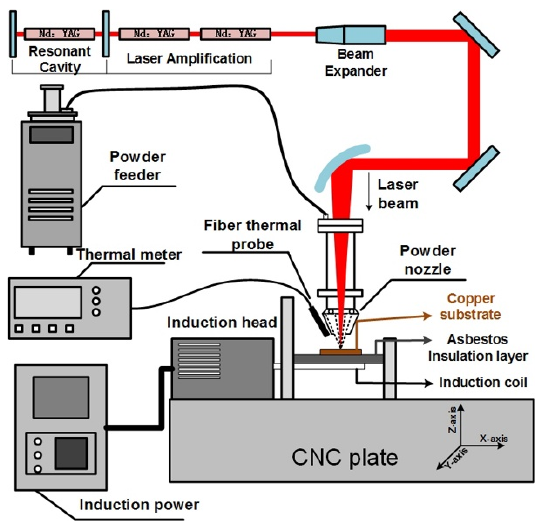
Figure 1. The schematic illustrating of pulse laser induction hybrid cladding (PLIC) system.